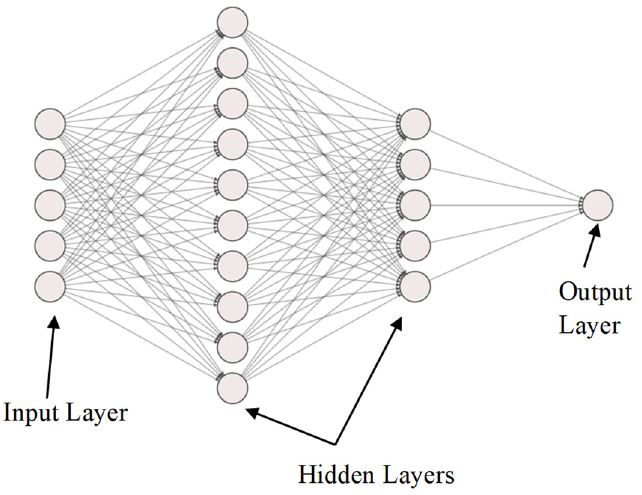
Figure 4. An example of DNN-MLP structure, composed of input, hidden, and output layers.